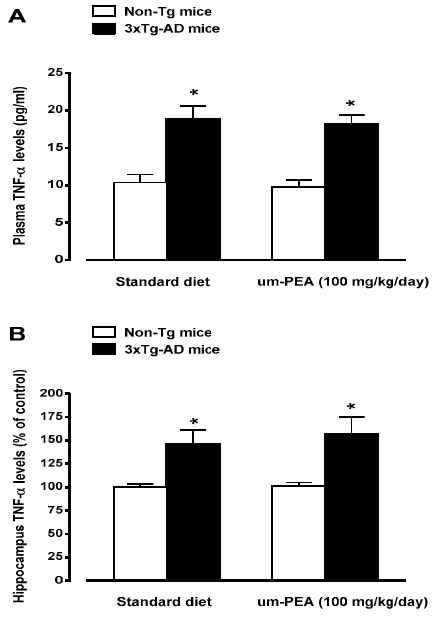
Figure 4. Effects of oral ultramicronized palmitoylethanolamide (um-PEA) treatment on plasma ( panel A ) and hippocampus ( panel B ) tumor necrosis factor alpha (TNF- α ) levels in non-Tg and 3×Tg-AD mice. Age-matched non-Tg mice and 3×Tg-AD mice (2 months ± 2 weeks of age) have been orally treated for 3 months with the compound (100 mg/kg/day, added to the animal food), while control animals were fed with a standard diet during the treatment period. Biochemical analyses were performed on hippocampus tissues taken from mouse brains at the end of the treatment period. The data are presented as absolute values ( panel A ) or as percentage ± SEM of control (standard diet-fed non-Tg mice; Panel B ) ( n = 4, in triplicate). * p < 0.05 significantly different from the respective non-Tg mouse group according to two-way ANOVA followed by Tukey multiple- comparison test.